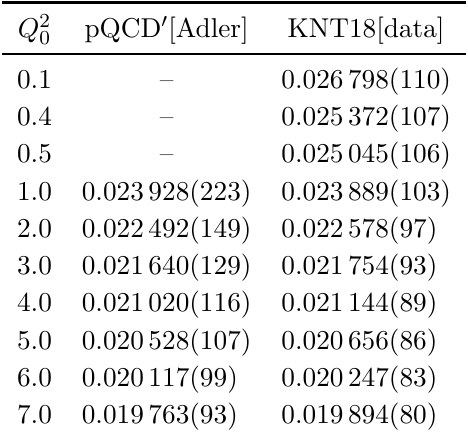
(cid:0) (cid:1) (cid:0) (cid:1) − M 2 − ∆α (5) − Q 2 ] for various threshold energy Q 2 0 Z had had